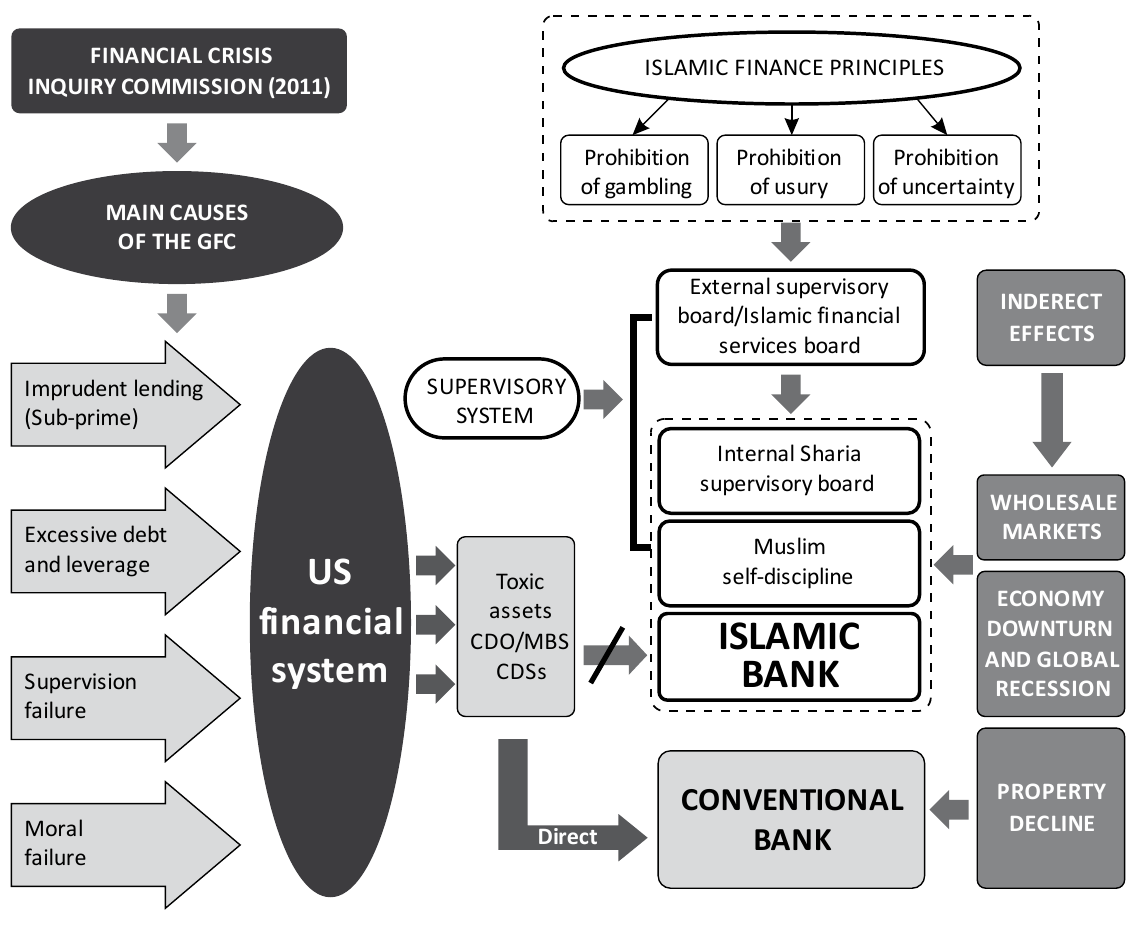
Figure 3. Intrinsic principles of the Islamic financial system potentially capable of safeguarding